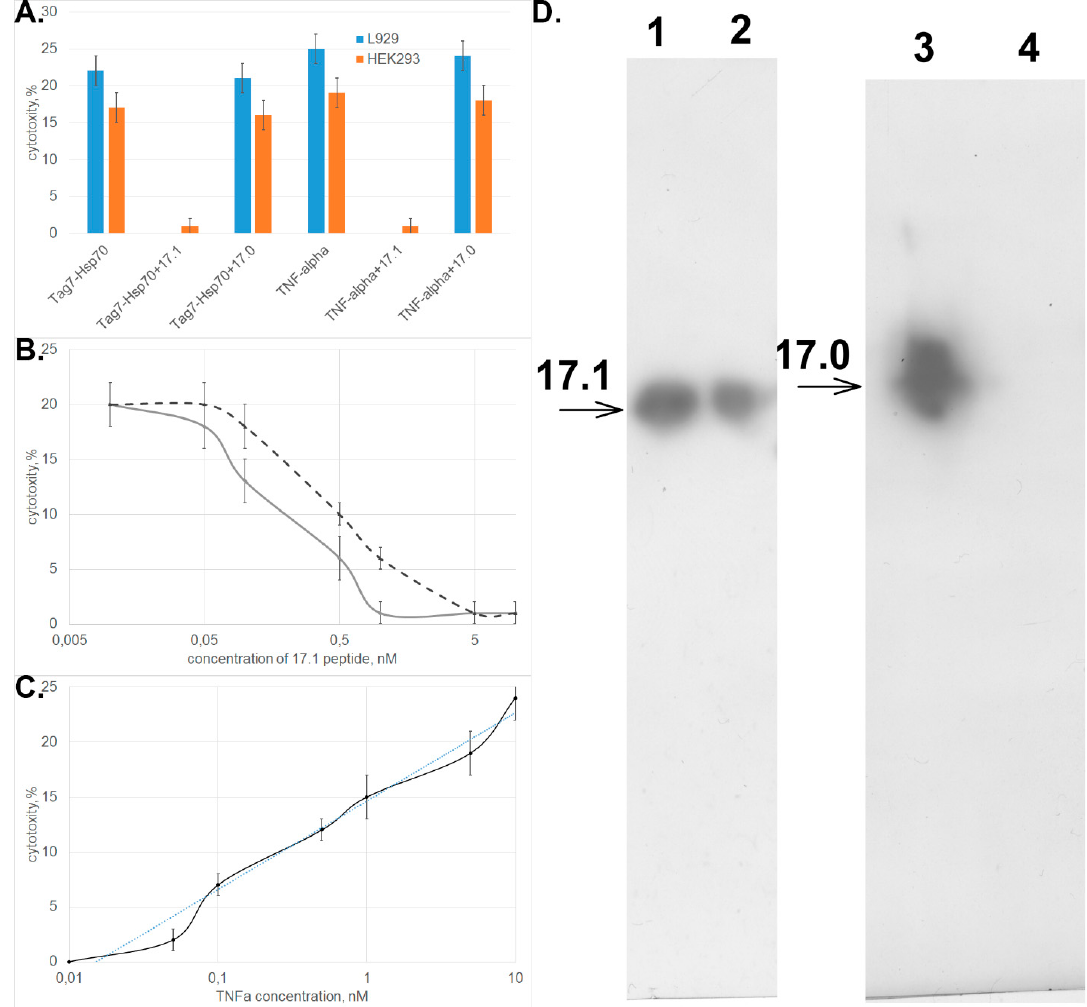
Figure 2. Peptide 17.1 can inhibit cytotoxicity of tumor necrosis factor (TNF α ) and the Tag7–Hsp70 complex. ( A ) Inhibition of cytotoxic activity of the Tag7–Hsp70 complex (10 − 10 M) and TNF α (5 × 10 − 11 M) in the presence of peptides 17.1 and 17.0 (10 − 9 M) on L929 cells or HEK293 cells. ( B ) Cytotoxicity after 20 h incubation of TNF α (5 × 10 − 11 M, solid curve) and the Tag7–Hsp70 complex Hsp70 (10 − 10 M, dashed curve) after preincubation of L929 cells in the presence of peptide 17.1 at increasing concentration. ( C ) Cytotoxicity after 20 h incubation of increasing concentrations of TNF α after preincubation of L929 cells in the presence of peptide 17.1 (10 − 9 M). All data are presented as mean ± SEM for at least three independent replicates. ( D ) Binding of peptides 17.1 and 17.0 to sTNFR1. (2, 3) control for peptides 17.1 and 17.0, respectively. (1, 4) elution of 17.1 and 17.0, respectively,